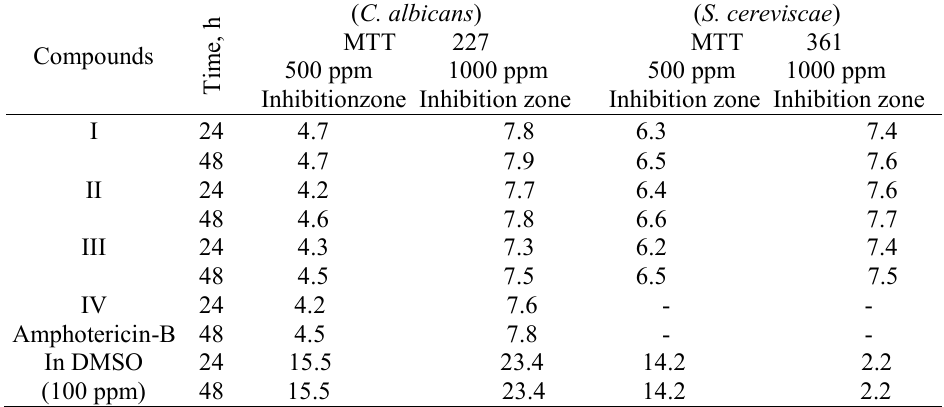
Table 2. Antifungal activities of newly synthesized transition metal complexes against S. cereviscae and C albicans